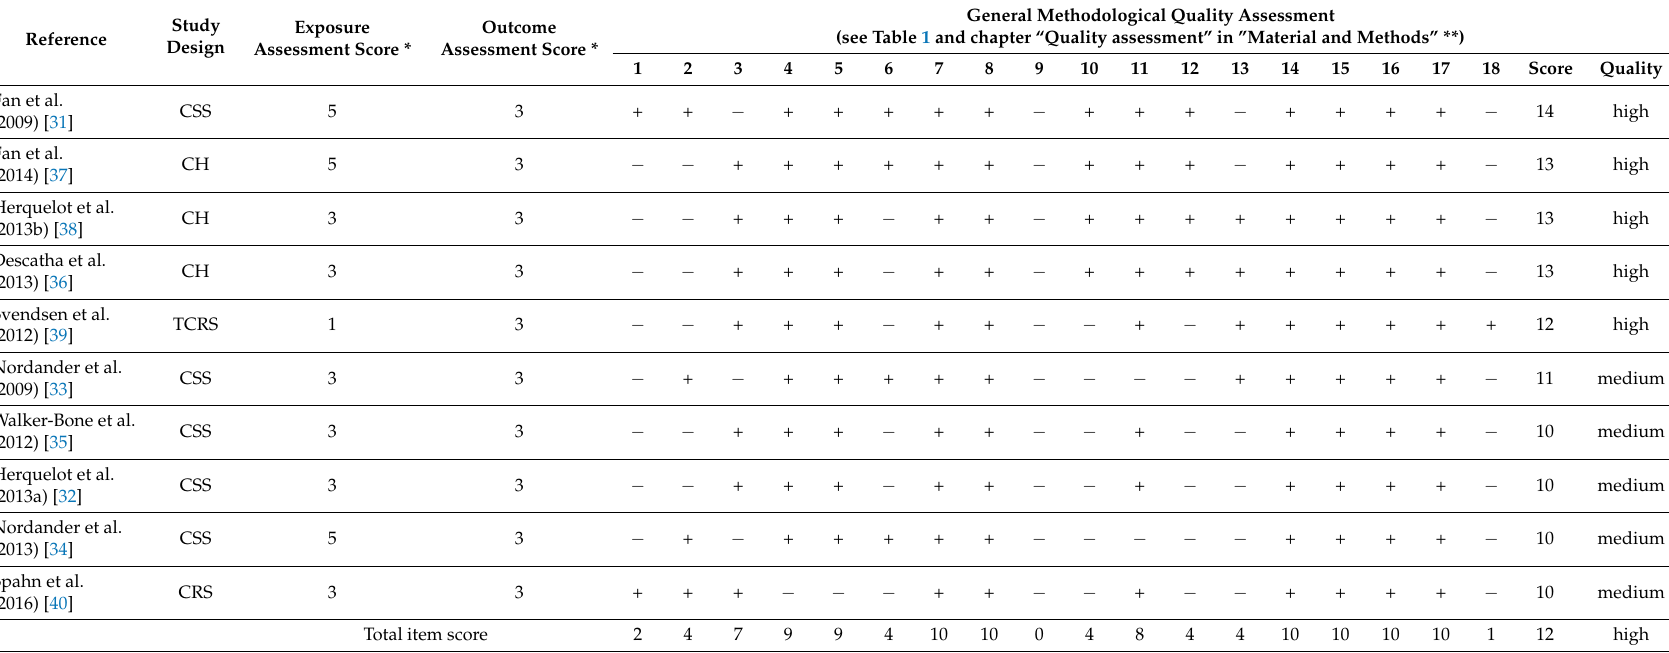
Table 3. Quality assessment of included